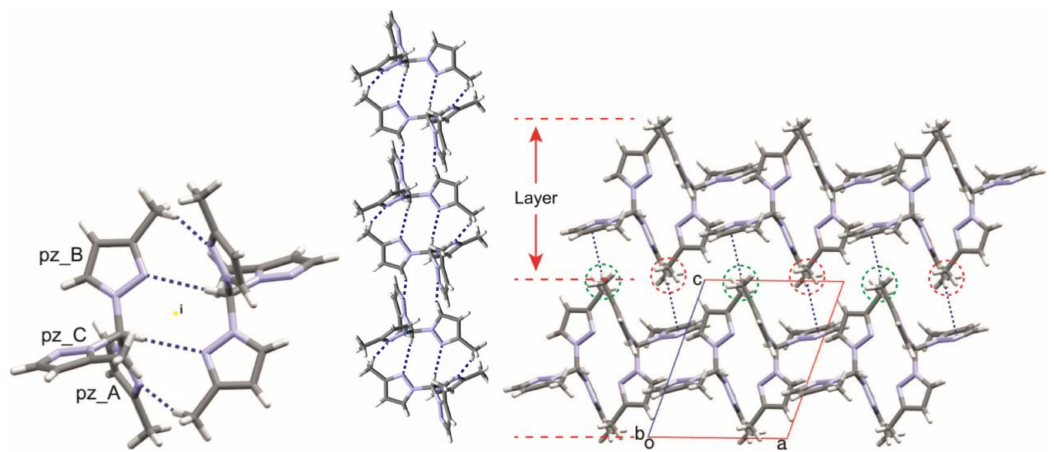
Figure 6. Three views of the structure of compound 335